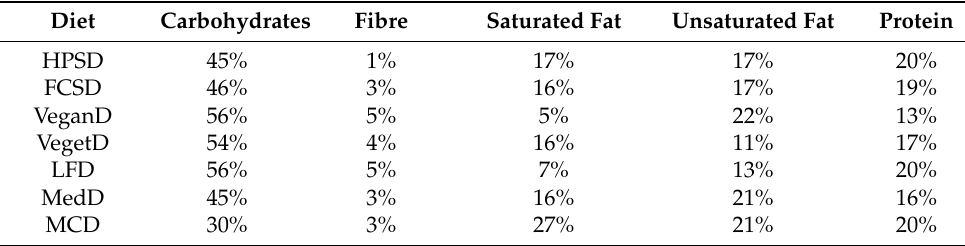
FCSD: Freshly cooked standard omnivore diet, HPSD: Highly processed standard omnivore diet, LFD: Low-fat normal-protein omnivore diet, MCD: High-fat, moderate-carb omnivore diet, MedD: Medium-fat, normal- protein Mediterranean omnivore diet, VeganD: Low-fat, low-protein vegan diet, VegetD: Low-fat, normal-protein vegetarian diet. The respective four-week food plans were composed and analysed using PRODI 6.2, which includes the Bundeslebensmittelschlüssel and the MONICA food list [30]. Dietary compositions of all food plans are presented in Table 2 (Macronutrients) and Table 3 (Micronutrients). Table 2. Actual dietary macronutrient composition of the model diets. Diet Carbohydrates Fibre Saturated Fat Unsaturated Fat